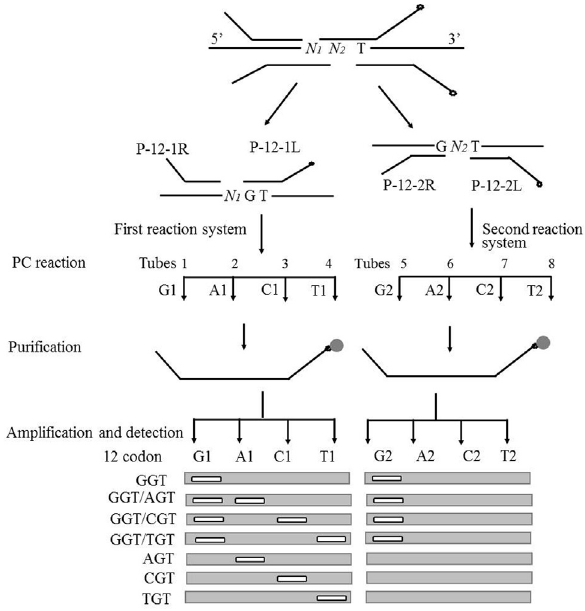
Figure 2 - Detection assay for codon 12 of K-ras . Open circles represent thebiotinlabel;closedcirclesarethesymbolofstreptavidin-coupledmag- netic beads; N1 and N2 represent the bases of G, A, C, and T; G1, A1, C1, T1, and G2, A2, C2, T2 represent the four reactions corresponding to each pair of detection